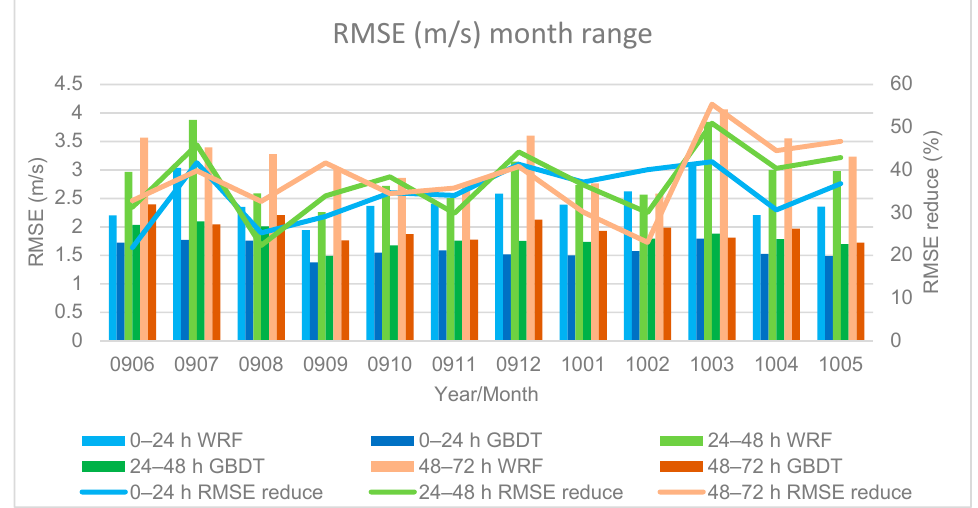
Figure 11. RMSE results in different month, contains the WRF original output (WRF), GBDT output (GBDT), and the RMSE reduction (%) of GBDT.